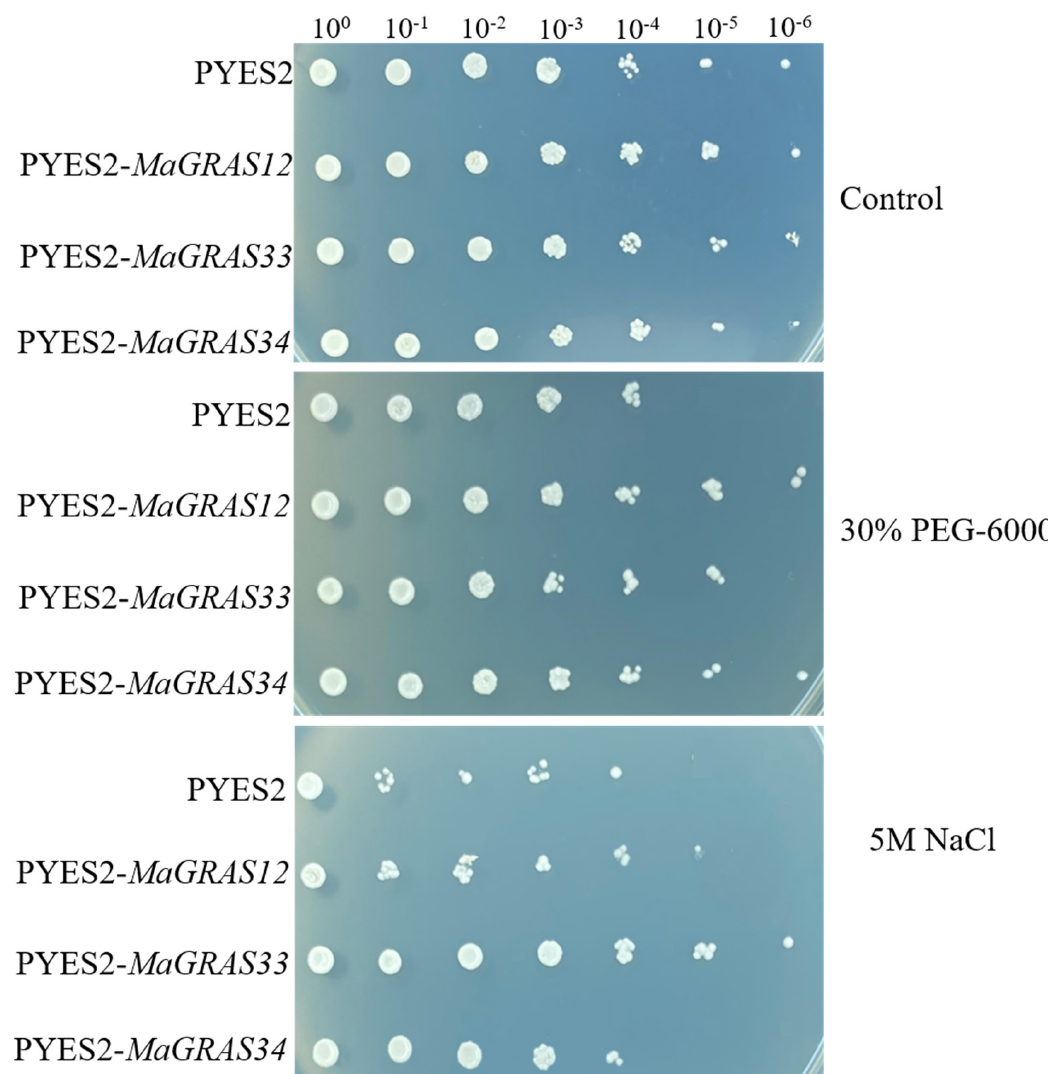
Figure 9. Drought and salt stresses tolerance analysis of MaGRAS12 , MaGRAS33 and MaGRAS34 in a yeast expression system, using yeast with empty pYES2 vector as control.